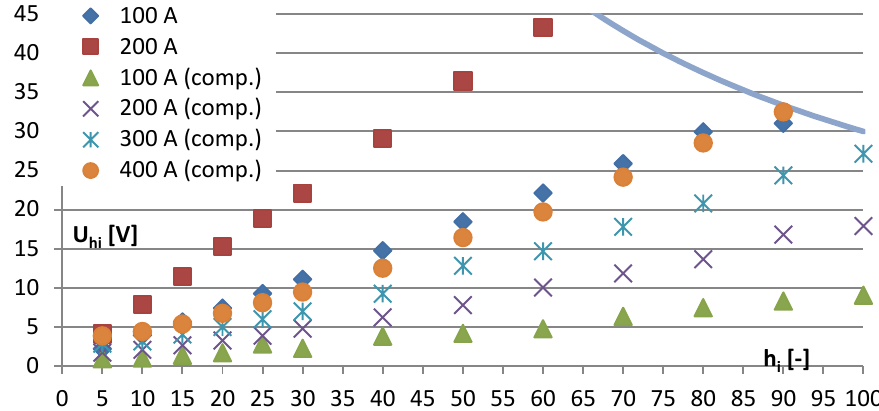
Figure 12. Required rms values of the harmonics of the output voltage to achieve with and without compensation a 10% higher harmonic of the output current of the step-up current transformer.